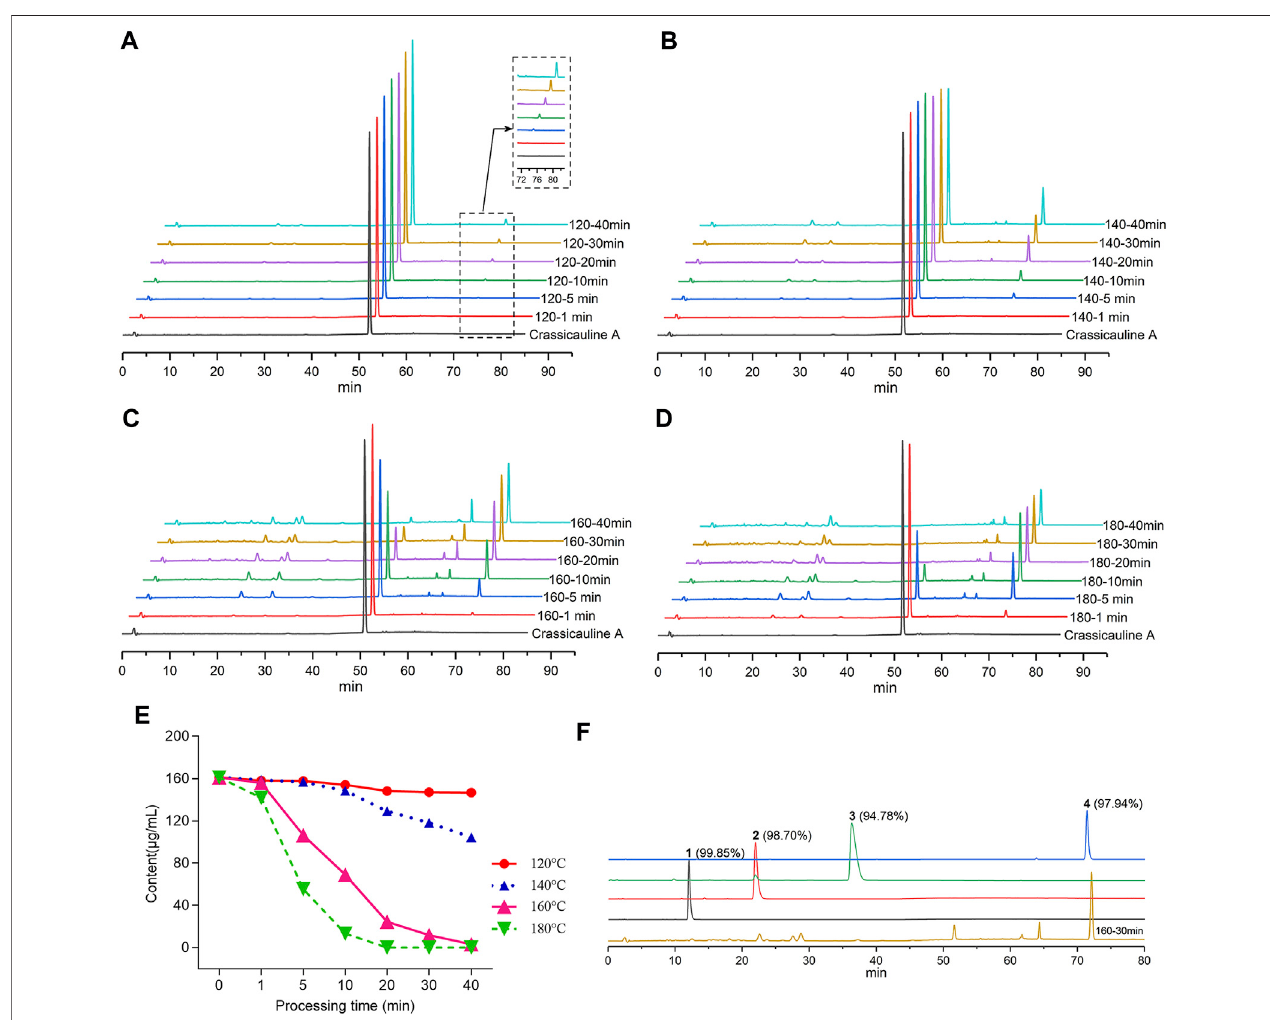
FIGURE 2 | Contents for crassicauline A of different processed products and purity test. (A – D) HPLC chromatograms of different carssicauline A processed products.(A:120 ° C,B:140 ° C,C:160 ° C,D:180 ° C). (E) ContentvarietyofcrassicaulineAunderdifferentprocessingtemperaturesandtime. (F) Purityofthetransformed